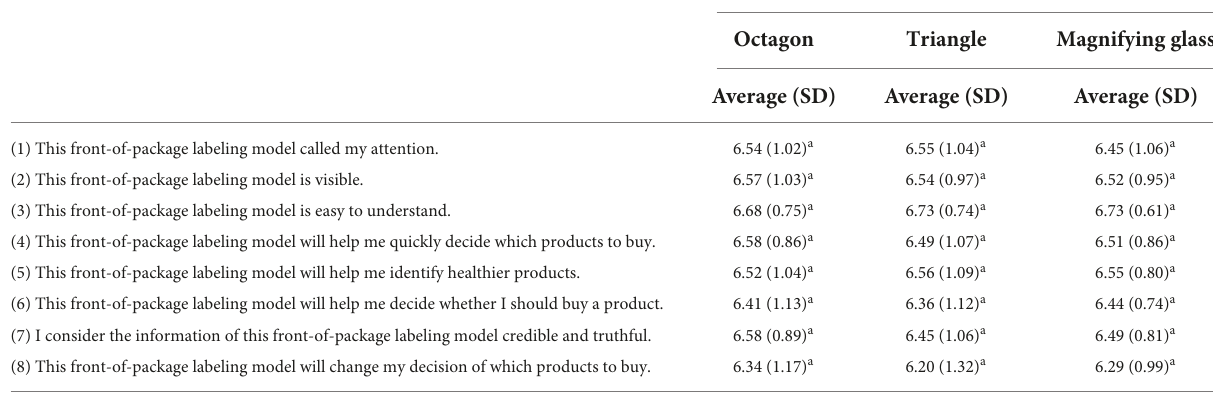
TABLE 7 Participant perception of the FoPNL models